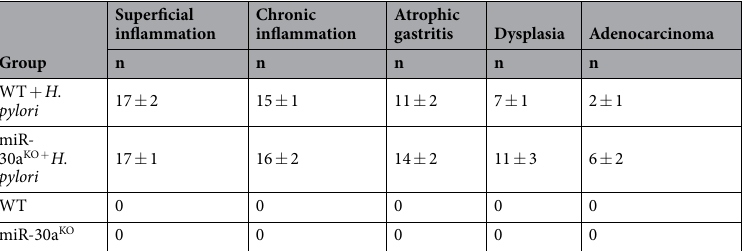
Table 2. Pathological examination for the gastric mucosa of the H. pylori -infected and -uninfected wild type (WT) mice or miR-30a KO mice (72 weeks, HE staining). Note: All the animal experiments were independently repeated three times, and the interval time between each time of experiment was about one month. In each experiment, the initial numbers of mice in each group for each time was 20. After 72 weeks, several of the 20 WT/ H. pylori mice or the 20 miR-30a KO / H. pylori mice died of natural